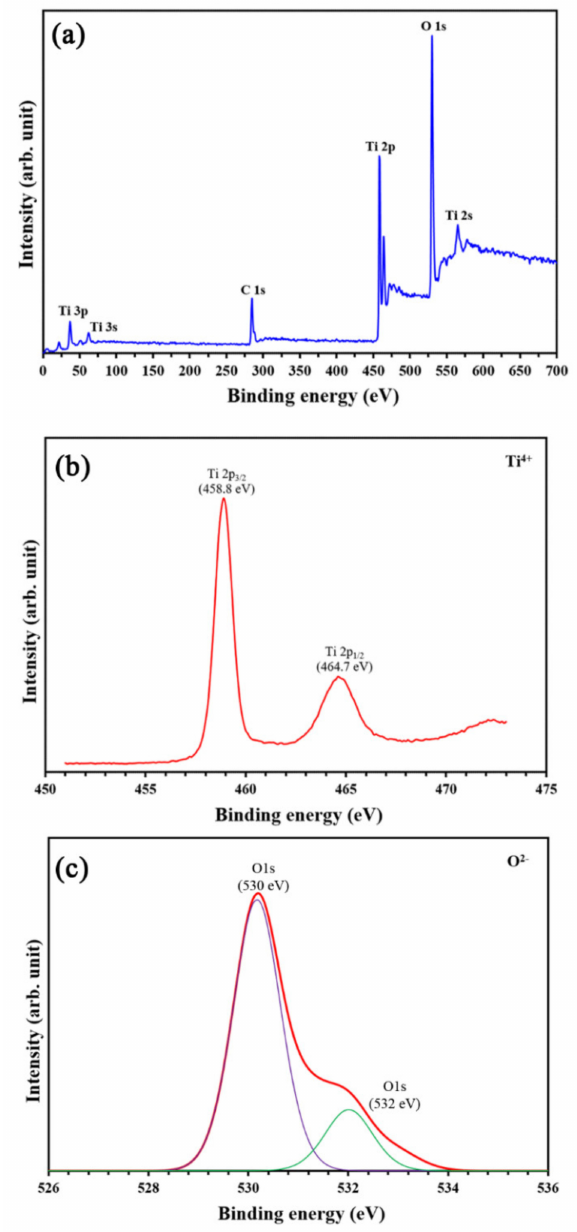
Figure 4. XPS spectra of ( a ) survey spectra, ( b ) spectra of the Ti2p, and ( c ) spectra of the O1s peaks of TiO 2 thin film coated on PVC